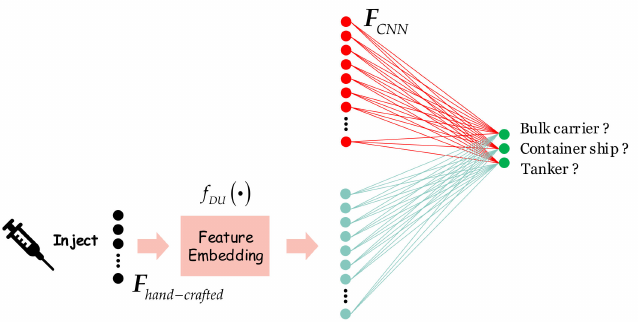
Figure 16. Diagrammatic sketch of the dimension unification concatenation